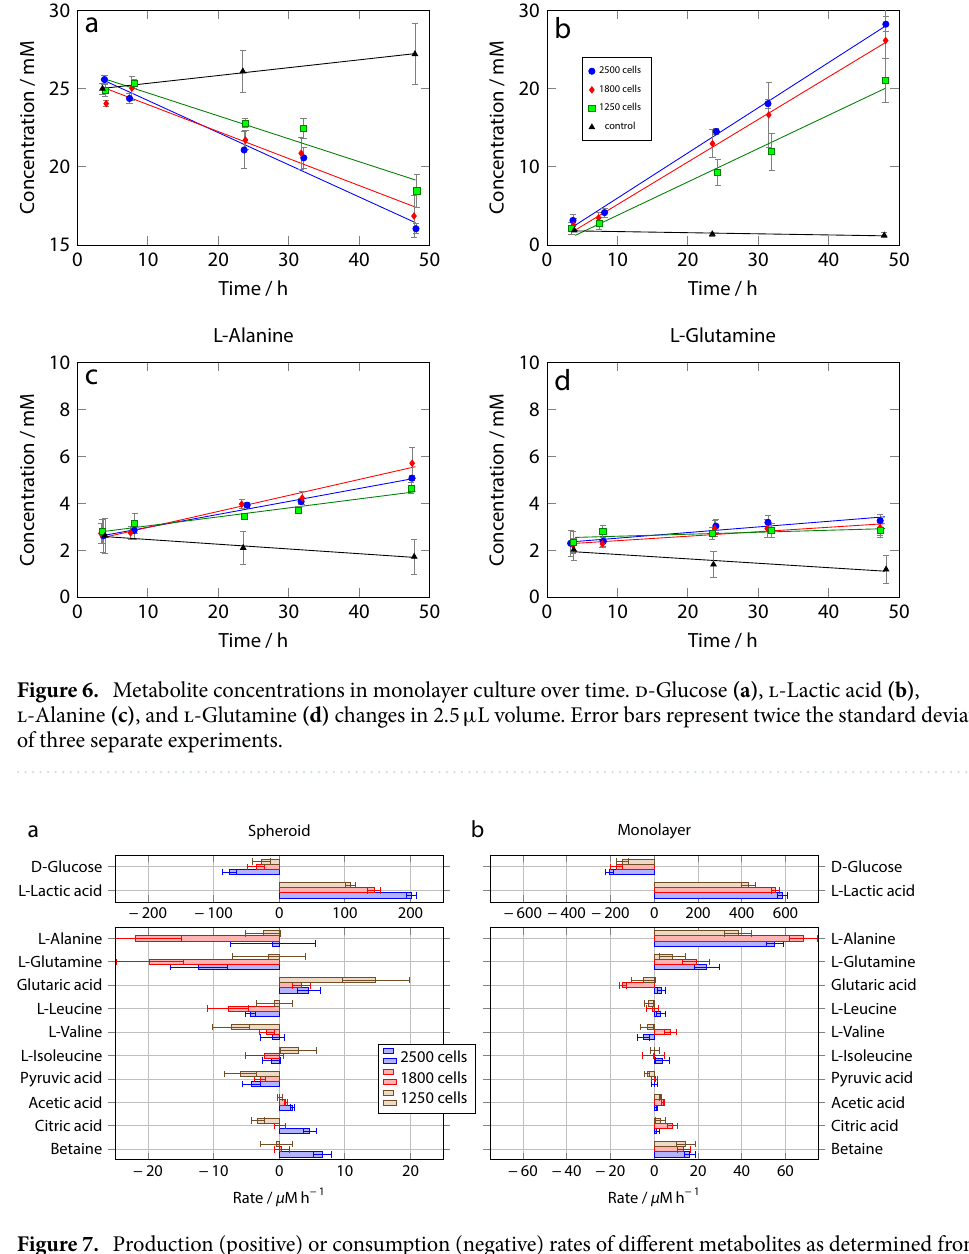
Figure 7. Production (positive) or consumption (negative) rates of different metabolites as determined from the NMR spectra for a single spheroid (a) and monolayer culture (b) . Note that the scale for the spheroid results is expanded threefold compared to the monolayer data. Error bars represent the standard deviation from three separate